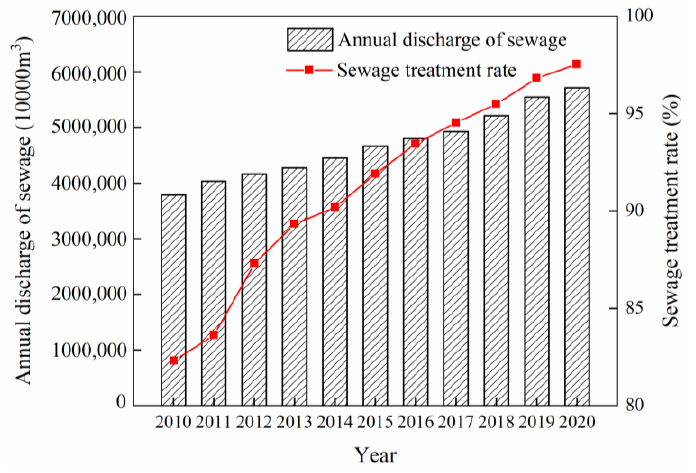
Figure 1. Annual sewage discharge and sewage treatment rate in China,